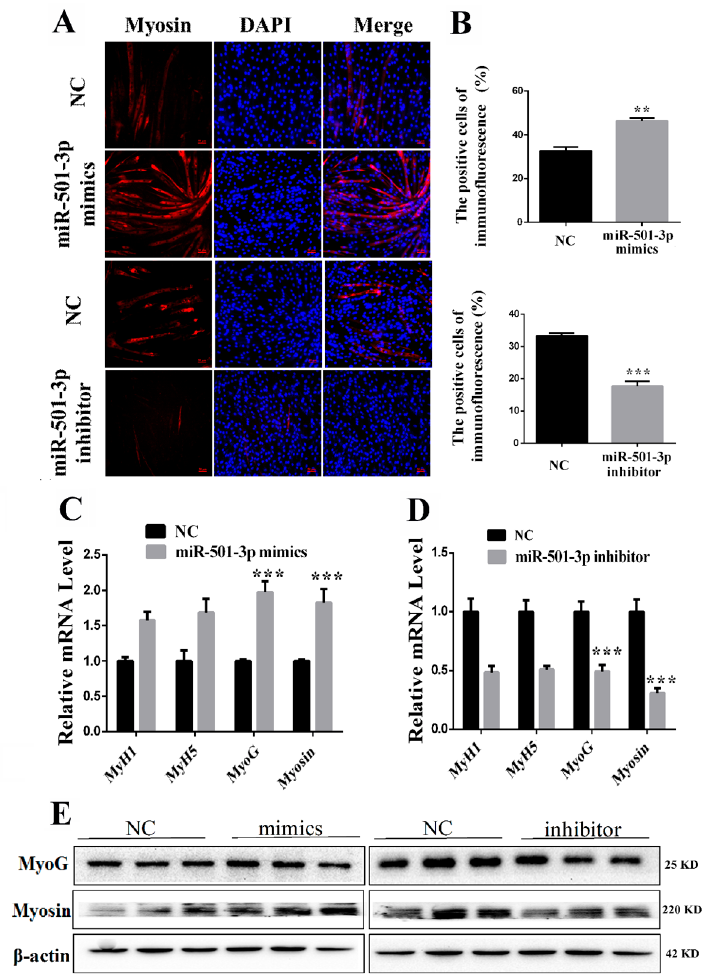
Figure 3. MiR-501-3p promotes C2C12 differentiation. We measured the expression of myogenic marker genes after C2C12 were transfected with miR-501-3p mimics or inhibitor. ( A ) MiR-501-3p mimics increased the percentage of Myosin-positive C2C12, and miR-501-3p inhibitor decreased the percentage of Myosin-positive C2C12. Representative images of the immunofluorescent staining for differentiated C2C12 are shown. Myosin: red, a molecular marker of myogenesis; DAPI: blue, cell nuclei; Merge: C2C12 fused into primary myotubes are shown in the insets. ( B ) The quantitative data of Myosin-positive C2C12 in Figure 3A. ( C ) The qRT-PCR confirmed miR-501-3p mimics increased ( p ＜ 0.05) mRNA level of myogenic marker genes after differentiation induction. ( D ) The qRT-PCR confirmed miR-501-3p inhibitor decreased ( p ＜ 0.05) mRNA level of myogenic marker genes after differentiation induction. ( E ) Western blot was used to measure the myogenic marker protein level after differentiation induction. ** p ＜ 0.01; *** p ＜ 0.001. The results are presented as mean ± S.E.M. of three replicates for each group. Magnification 100×. The scale bar on the photomicrographs represents 50 μ m.